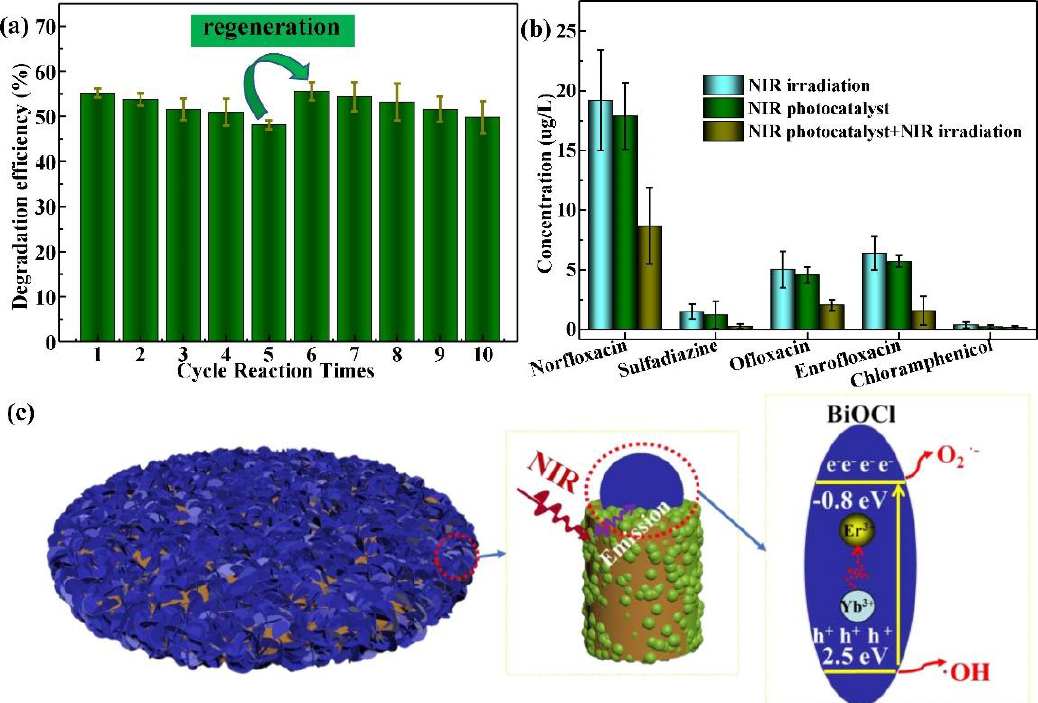
Figure 18. ( a ) Regeneration degradation of Norfloxacin efficiencies under NIR light. ( b ) Degradation concentration of Norfloxacin, Sulfadiazine, Ofloxacin, Enrofloxacin and Chloramphenicol in concentrated leachate under NIR light. ( c ) The photocatalytic mechanism of NIR GC photocatalyst. Reprinted with permission from Ref. [126].